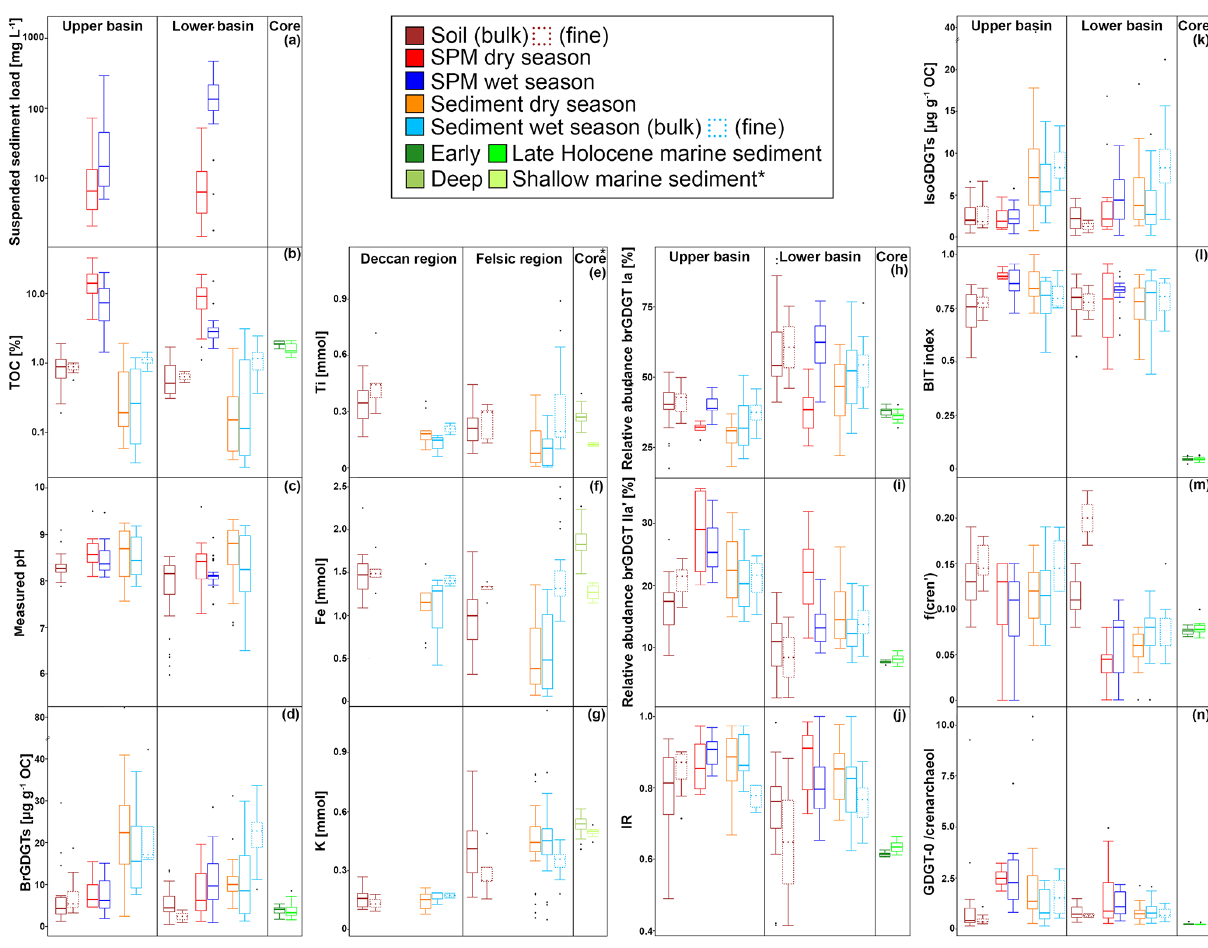
Figure 2. Box-and-whisker plots of the organic, geochemical, and GDGT data for the Godavari basin and marine sediments in the Bay of Bengal. (a) Suspended sediment load, (b) total organic carbon (TOC), (c) measured pH, and (d) brGDGT concentrations normalised to %OC in the upper and lower basin and in Holocene marine sediments. (e) Ti, (f) Fe, and (g) K amounts in the Deccan basalt and felsic bedrock regions, and ∗ in shallow (0–48cmb.s.f., ∼ 300 years; Kalesha et al., 1980) and deep marine sediments (0–300m (NGHP- 1-3B) and 0–184mb.s.f. (NGHP-1-5C), no age model used; Mazumdar et al., 2015). (h) Relative abundance of brGDGT Ia, (i) relative abundance of brGDGT IIa (cid:48) , and (j) isomer ratio (IR) values in the upper and lower basin and in Holocene marine sediments. (k) Isoprenoid GDGT concentrations normalised to %OC, (l) BIT index, (m) f (cren (cid:48) ), and (n) GDGT-0 / crenarchaeol in the upper and lower basin and in Holocene marine sediments. The box represents the first (Q1) and third (Q3) quartiles, and the line in the box represents the median value; the whiskers extend to 1.5 × (Q3–Q1) values, and outliers are shown as points. Solid lines represent bulk data, and dashed lines